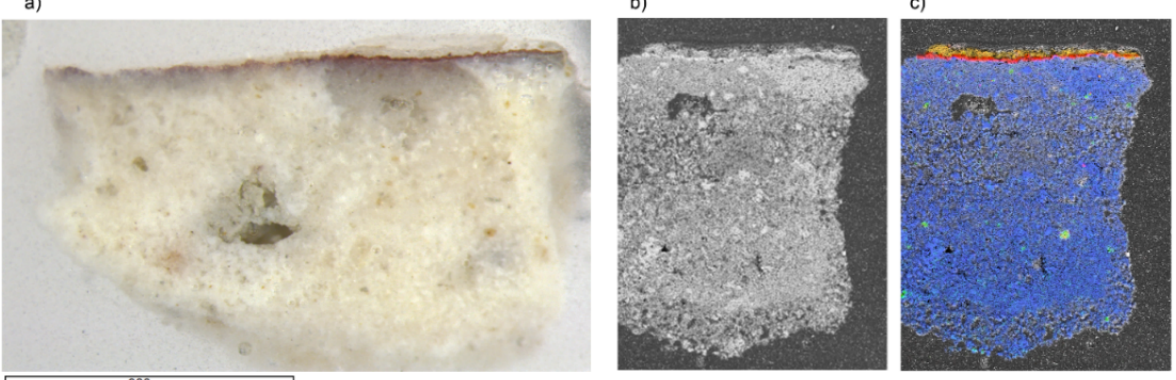
Figure 6. ( a ) Optical microscopy image of sample R. ( b ) SEM image of sample R (BSE mode) and ( c ) SEM-EDX results of sample R: superposition of elemental maps of calcium (blue), iron (red), sulphur (yellow), and silicon (green).